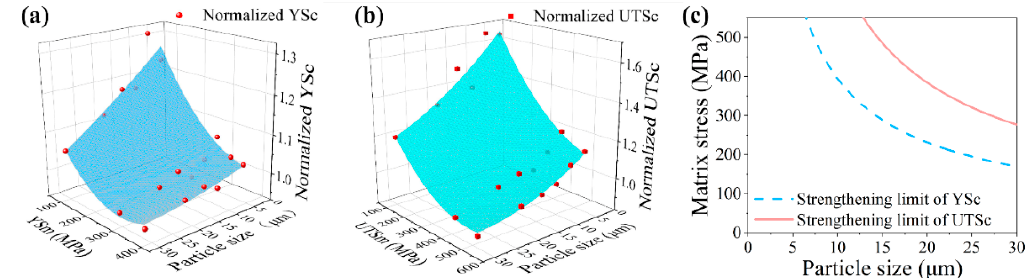
Figure 6. The relationship of ( a ) normalized composite yield strength (normalized YSc) and ( b ) normalized composite ultimate strength (normalized UTSc) with the particle size and the matrix yield strength and the ultimate strength (YSm and UTSm), respectively. The normalized strength is normalized to the strength of its matrix. ( c ) The strengthening limits of the composite strength obtained by numerical fitting. The matrix strength on the Y axis represents the YSm or UTSm when the strengthening limit line of YSc or UTSc is used.